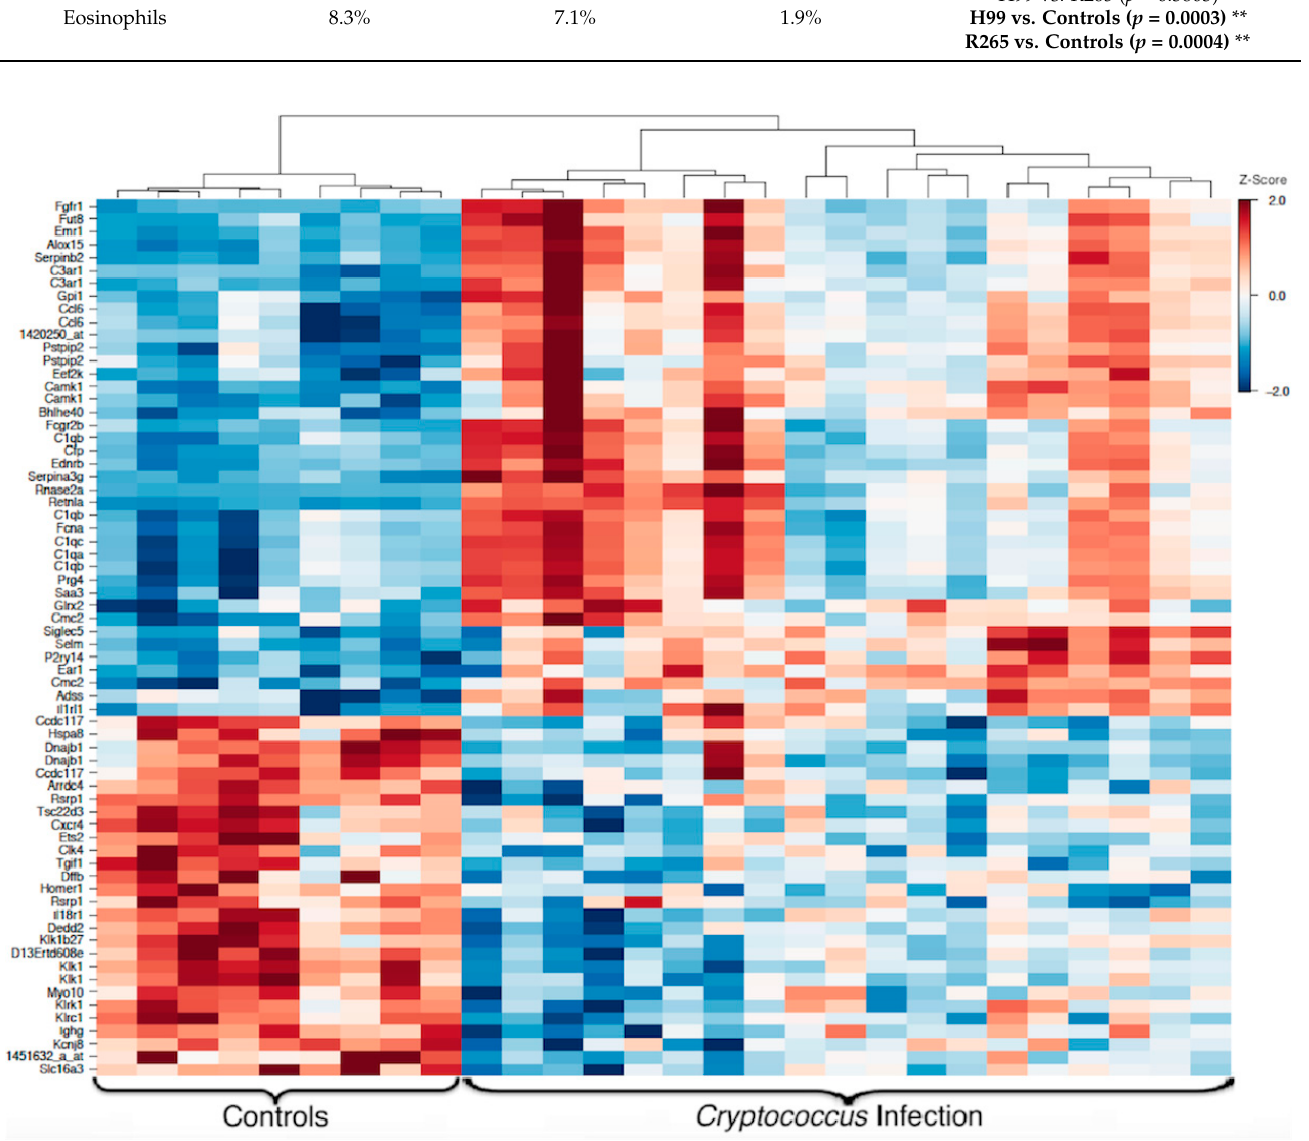
Figure 3. Heat map of genes differentially expressed between infected and healthy mice. Solid red indicates a Z-score of 2.0 or greater, while solid blue indicates a Z-score of − 2.0 or lower. Gene names are listed on the left, while clustering is indicated at the top of the figure.